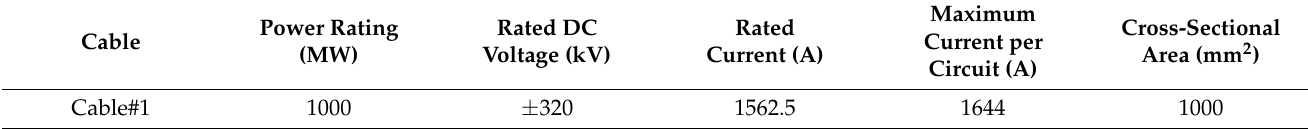
Table A10. DC-cable design for Architecture 4.